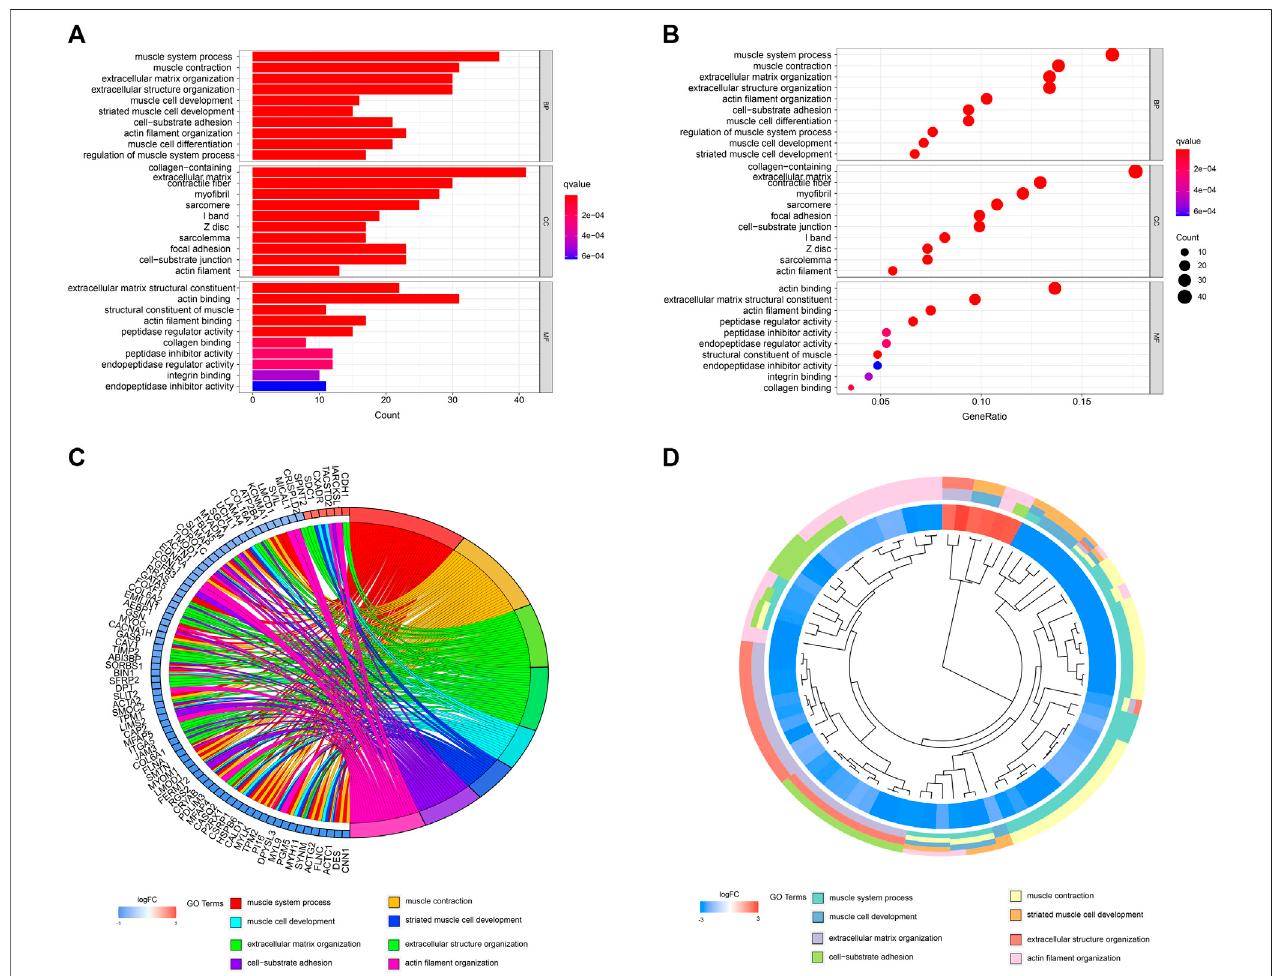
FIGURE 3 | (A,B) Detailed information relating to changes in the biological processes (BP), cellular components (CC) and molecular functions (MF) of DEGs in control and treatment group through GO enrichment analysis. (C,D) Characteristic changes in up- and downregulated DEGs and their relationships with different BPs, CCs and